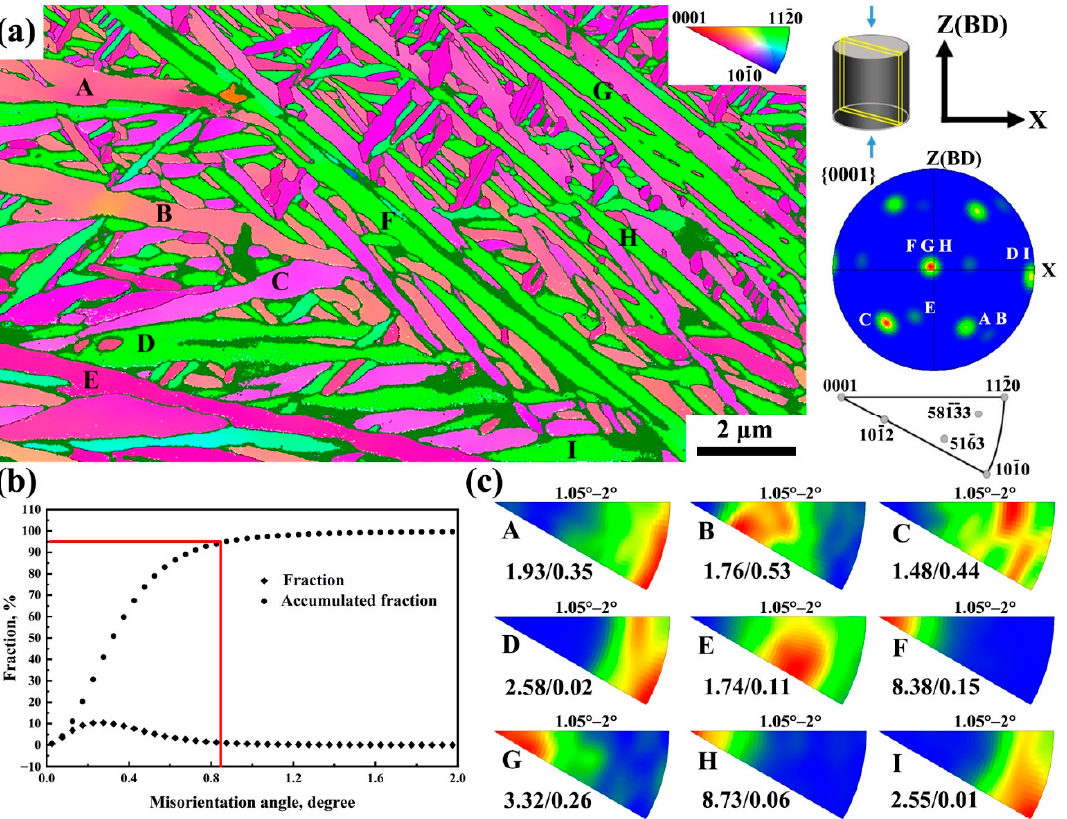
Figure 3. IGMA distribution of longitudinal compressed samples: ( a ) IPF map of a typical area; ( b ) fraction and accumulated fraction of misorientation angles below 2°; ( c ) IGMA distribution of individual grains in ( a ).